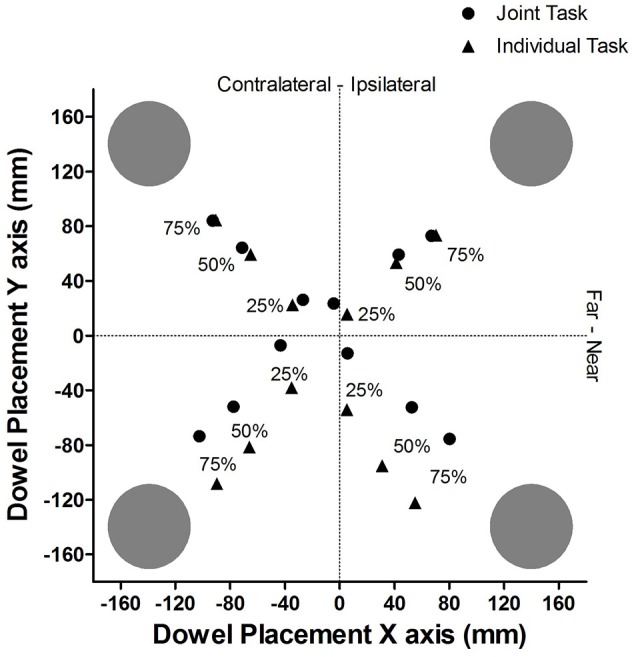
Experiment 1: Mean dowel placement in absolute coordinates for each cue validity and task condition.